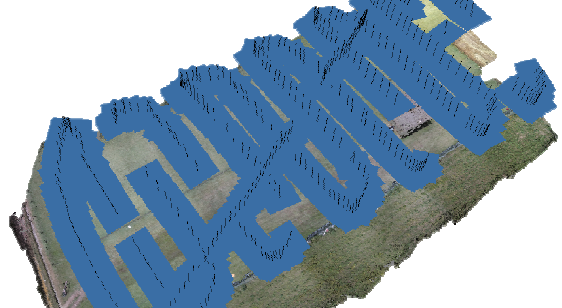
Figure 13. Images alignment performed by Agisoft Photoscan Professional